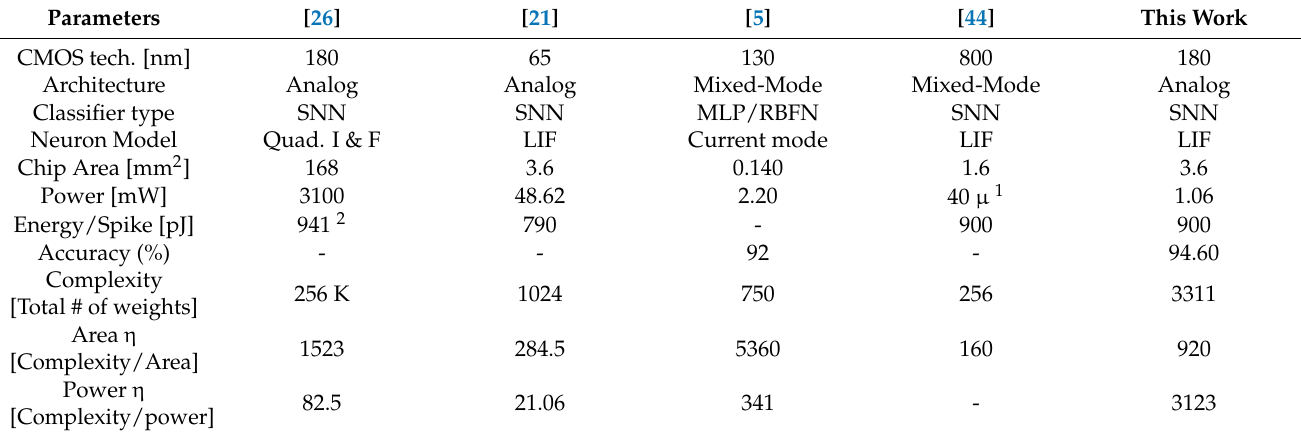
Table 3. Comparison of Performance of the SNN Chip with Other State of the Art Neuromorphic Chips.